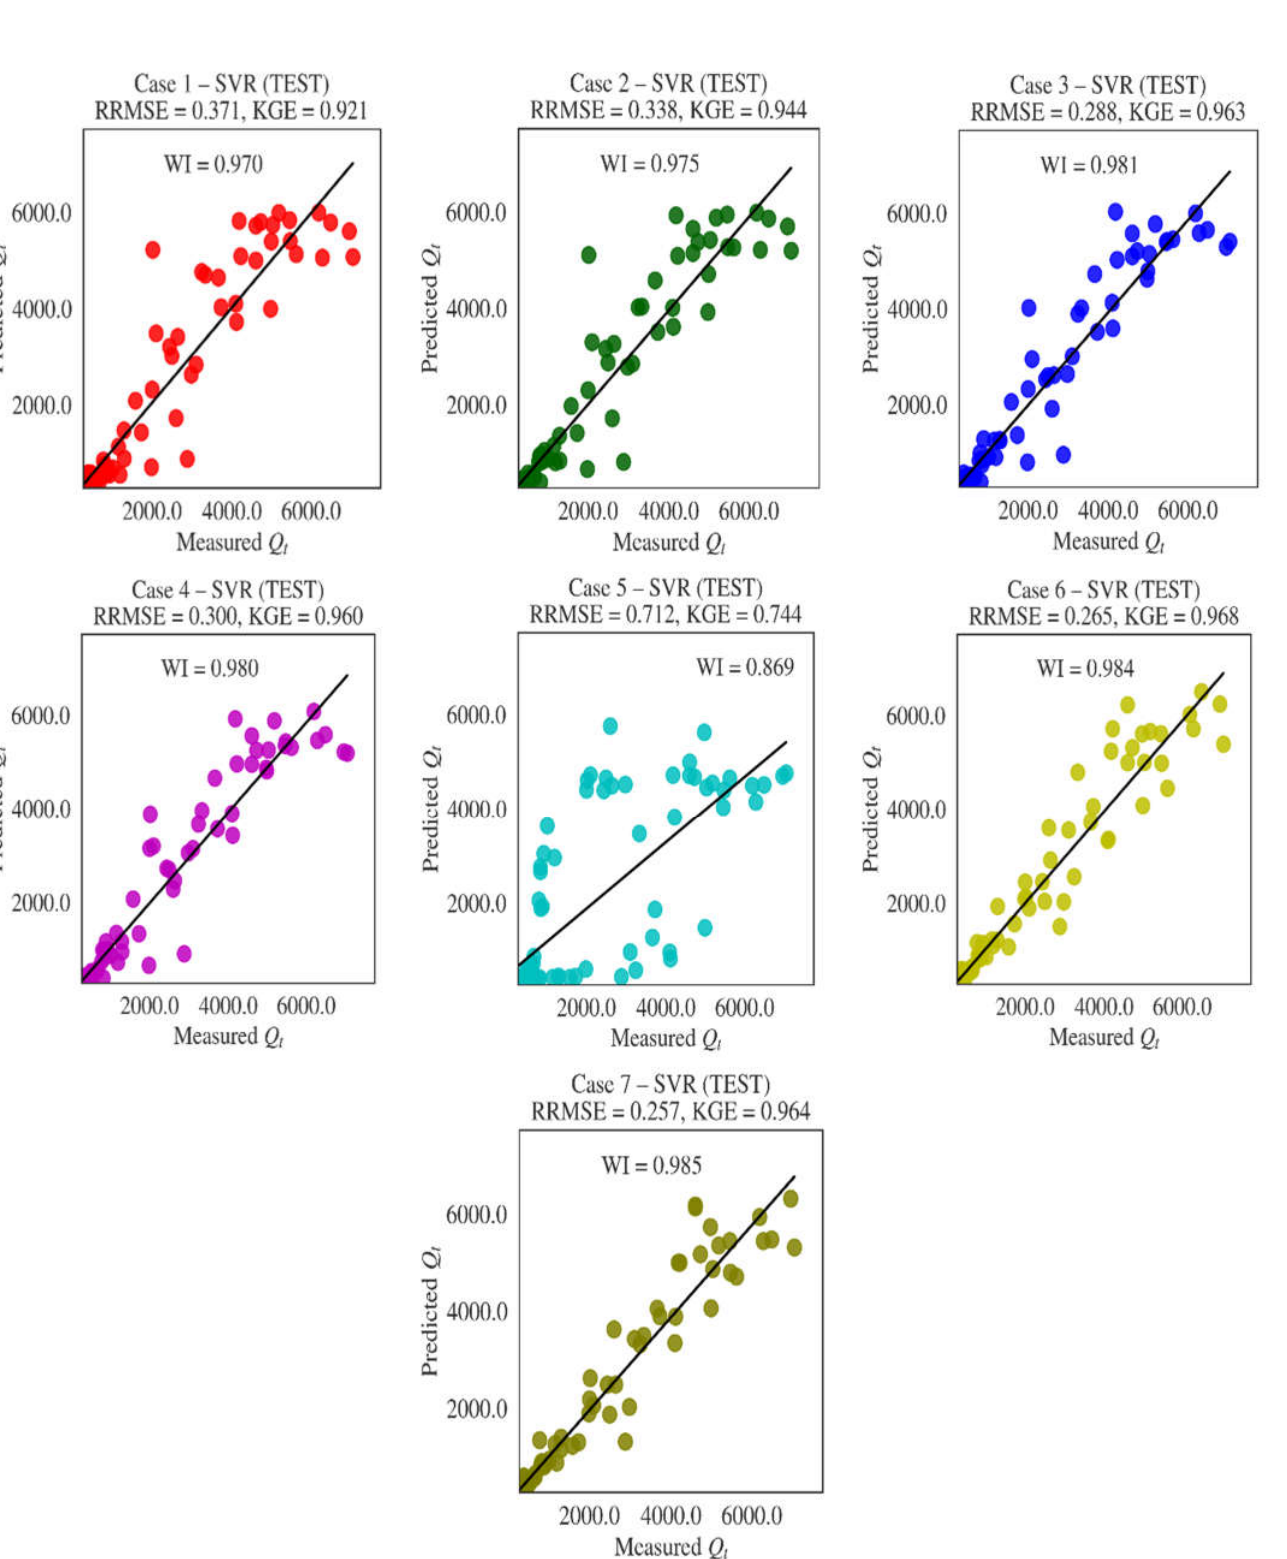
Figure 5. Scatterplots of the observed and predicted streamflow by the best models in the test stage.